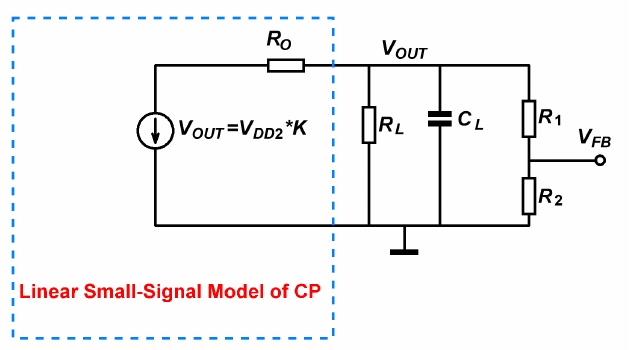
Figure 4. Linear small-signal model of the proposed charge